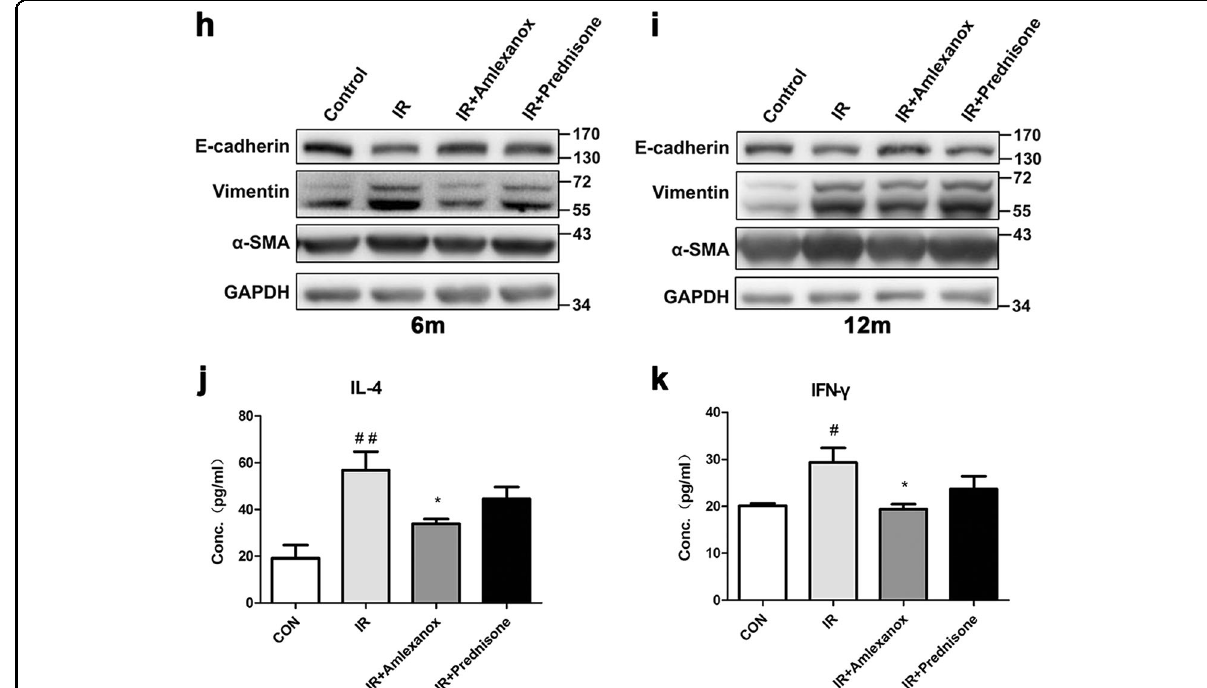
Fig. 8 (See legend on previous page.)